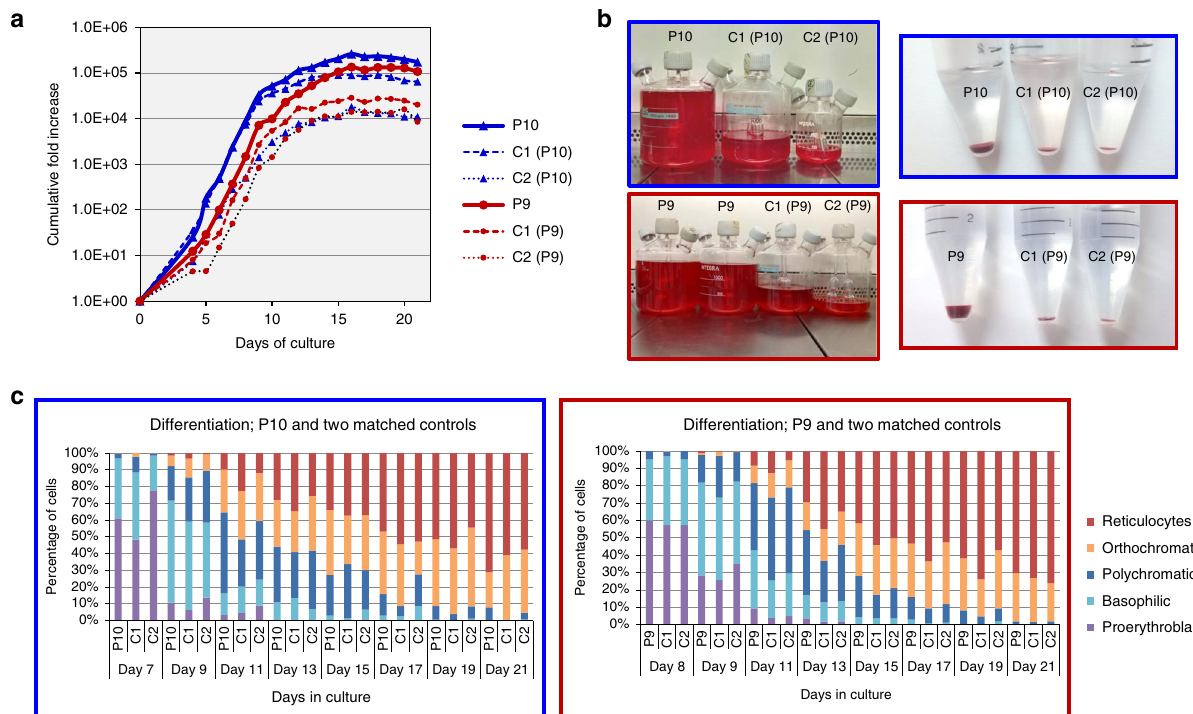
Fig. 5 CD34 + cells isolated from two MAM-negative whole blood samples, P9 (red) and P10 (blue) and cultured under explicit proliferation conditions following the three-stage protocol described by Grif fi ths et al. 18 in two ex vivo cell culture experiments showed enhanced erythroid proliferation compared to their respective age and gender-matched controls (C1 and C2). a Standardised cumulative fold proliferation of erythroid cells in cultures. In each experiment, all samples were maintained at equal cell densities, with passaging carried out as necessary. MAM-negative cultures showed greater expansion compared to the averaged expansion of their respective controls (7.5-fold greater in P9 and 4.62-fold greater in P10 on day 21). Proliferation data from additional cell culture experiments with P9 and P10 supported these fi ndings and are presented in Supplementary Fig. 6. Source data are provided as a Source Data fi le. b As cell cultures were adjusted to maintain equal cell densities, markedly different fi nal volumes were obtained at the end of the culture. On day 21, enucleation rates of both MAM-negative and control samples were approximately 70%. All samples (total volumes) were fi ltered using a standardised fi ltration protocol. Purity of resulting reticulocyte population was >99.2% in all samples. Comparison of packed cell pellets of fi ltered reticulocytes re fl ected the greater proliferation capabilities observed in the MAM-negative cultures. c The morphological pro fi les of the MAM-negative and matched control cells at different stages of erythroid cultures were very similar. No signi fi cant differences in the erythroid cell types between MAM-negative and matched controls were observed, with the exception of P9 and P10 reticulocytes (ANOVA repeat measures; P = 0.01), suggesting that the prevalence of each cell type remained constant between the cultures. Therefore, the enhanced MAM-negative cell proliferation was not the result of imbalanced or altered erythroid differentiation. Source data are provided as a Source Data fi Our data are consistent with a role for EMP3 in the membrane Table 1. Additional rare phenotype red blood cells (RBCs) and antisera were obtained from the IBGRL rare reference collection. Ethylenediaminetetraacetic acid assembly of a signalling complex with CD44 in the plasma (EDTA) peripheral blood samples from voluntary NHSBT blood donors, who had membrane of erythroid cells which participates in the regulation consented to the use of their blood for research purposes, were used as MAM- of cellular proliferation. There is considerable interest in gen- positive controls. Fresh blood samples were obtained from patient P9 and family erating therapeutic quantities of red cells in vitro for patients to members; P9-mother, P9-father and P9-sibling, following informed consent. P10 is whom blood group compatible blood is dif fi cult or impossible to a blood donor and waste products (EDTA whole blood tubes and citrated buffy coats from waste bags produced in the Reveos blood component system) from source (reviewed in Severn and Toye) 26 . Further elucidation of regular blood donations were obtained from this donor and age- and gender- the EMP3:CD44 complex in erythroid cells may provide a route matched control donors following approval by the advisory board at the Depart- to manipulation of ex vivo erythroid cultures to optimise yield of ment of Clinical Immunology and Transfusion Medicine in Lund, Sweden. All red cell product. Furthermore, clari fi cation of the composition materials were anonymized at the blood centre. and role of the EMP3:CD44 complex in other cells and tissues offers an approach to understanding and manipulating the Enzyme treatment and chemical modi fi cation of RBCs . RBCs were treated with papain (NHSBT Reagents) and peptide-N-glycosidase-F (PNGase F; New England tumour suppressor and oncogenic properties of EMP3 in diverse Biolabs). All incubations were carried out at 37 °C. For papain treatment, one cancers. volume of washed packed RBCs was incubated with two volumes of papain for 3 min, according to manufacturer ’ s instructions. For PNGase F treatment, aliquots of 200 µl of washed packed RBCs were incubated >14h in 300 µl of treatment buffer containing PNGase F, as per manufacturer ’ s instructions. Following all treatment incubations, RBCs were washed a minimum of four times with phosphate-buffered saline (PBS) until the wash supernatant was clear.